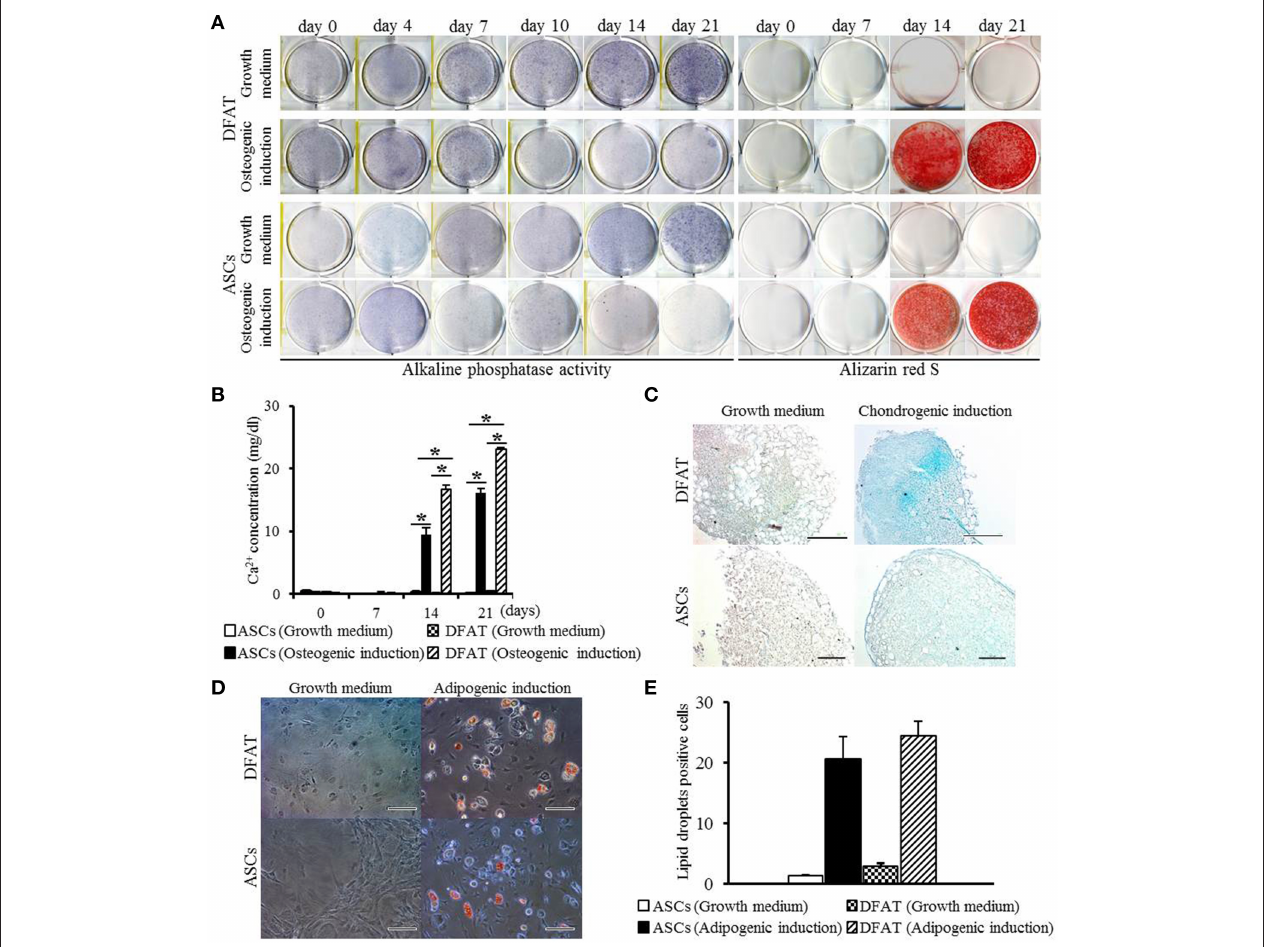
FIGURE 4 | Multilineage potential of DFAT cells and ASCs. (A) ALP activity and Alizarin red staining, examined to detect osteogenic potential of DFAT cells, and ASCs. (B) Calcium concentration determined by quantitative colorimetric assay. Each bar represents the mean ± SD ( n = 12 ); * P < 0.05. (C) Cells stained for Alcian blue to determine chondrogenic differentiation. Scale bar = 100 µ m. (D) Adipogenic differentiation evaluated by staining with Oil red O. (E) Oil red O-positive lipid droplets were measured in DFAT cells and ASCs under growth and adipogenic induction media. There was no significant difference between DFAT cells and ASCs on the cell number stained by Oil red